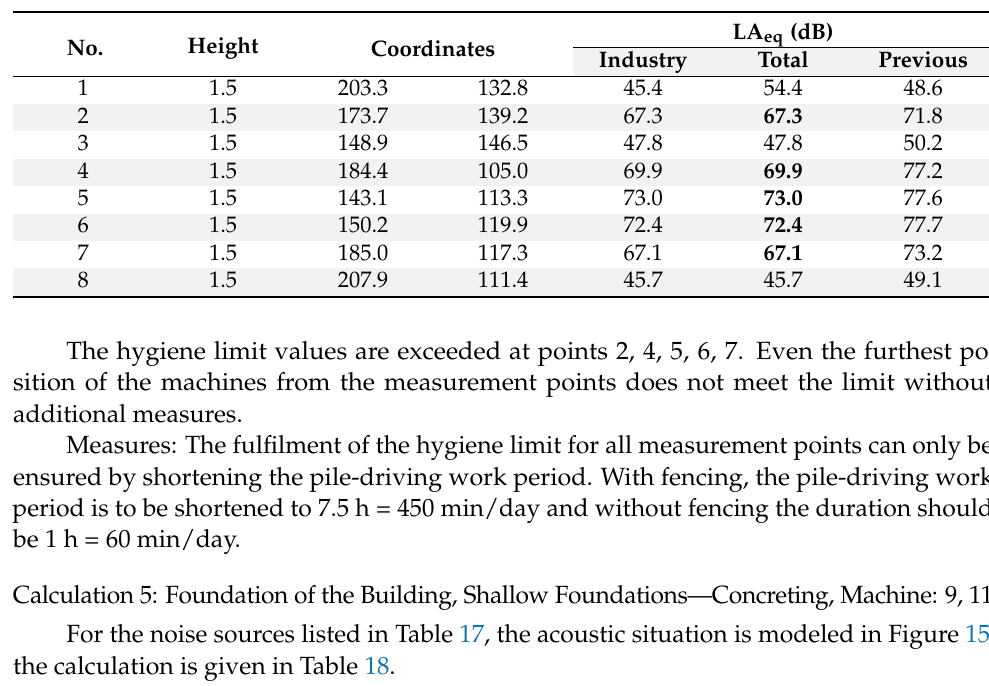
Figure 14. Colour map of isophone bands after considering acoustically significant elements (without construction site fencing or a solid gate) for pile-driving work in the investigated area, with the positions of machines. Table 16. Table of points from the calculation of measured points for pile-driving work without construction site fencing or a solid gate.